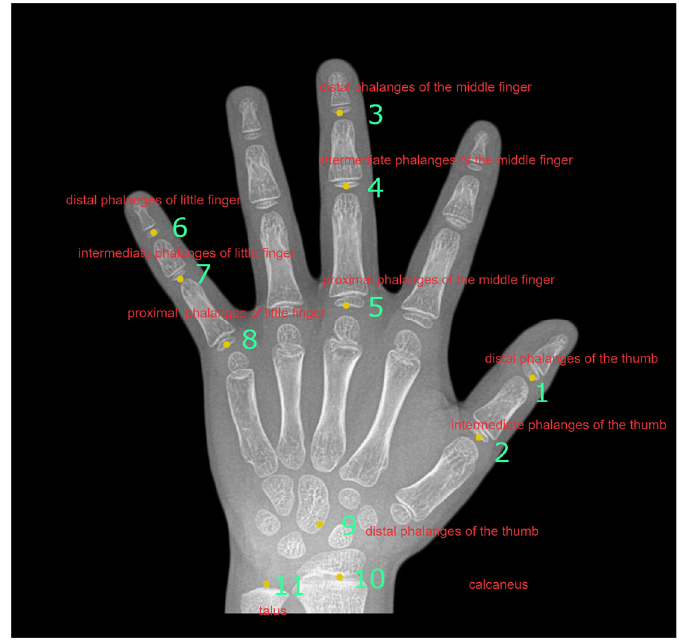
Figure 1. Eleven bone ROIs used in this